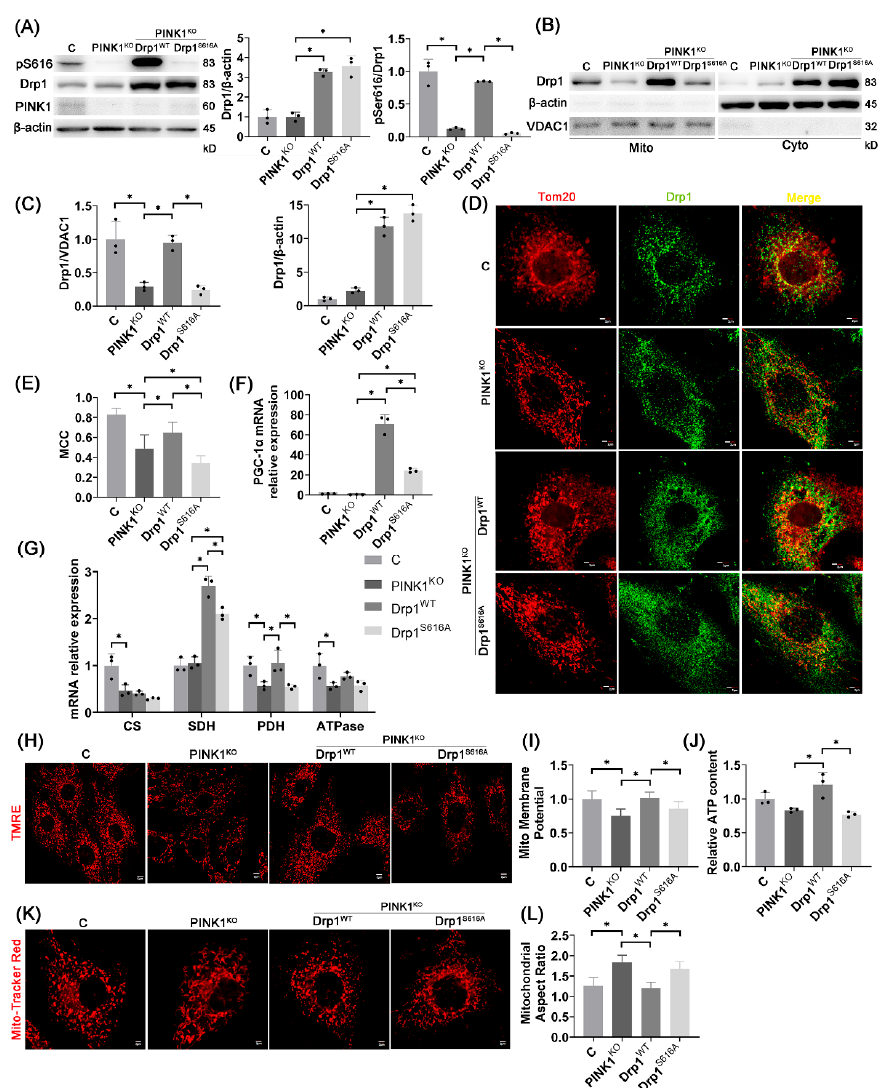
Figure 5. Overexpression of Drp1 WT , rather than Drp1 S616A , improve mitochondrial fission and func- tion. ( A ) PINK1 protein expression, Drp1 total protein level and Drp1 S616 phosphorylation level after PINK1 KO cardiomyocytes overexpressed Drp1 WT or Drp1 S616A ; n = 3 per group. ( B , C ) Drp1 protein levels on mitochondria and in cytoplasm after separation of mitochondrial and cytoplasmic proteins of H9C2 cardiomyocytes; n = 3 per group. ( D , E ) Representative images of immunofluorescence of H9C2 cardiomyocytes (red: mitochondrial outer membrane marker, Tom20, green: Drp1, blue: DAPI, Scale bar: 2 μ m) ( D ) and Manders co-localization coefficient (MCC) quantitative analysis of Tom20 and Drp1 (more than 30 cells analyzed per group) ( E ). ( F , G ) mRNA expression of mitochon- drial function-related gene PGC-1 α ( F ) and CS, SDH, PDH, ATPase ( G ) in H9C2 cardiomyocytes, n = 3 per group. (H, I) Representative images of TMRE mitochondrial membrane potential fluores- cence staining (Scale bar: 5 μ m) ( H ) and quantitative analysis of mitochondrial membrane potential fluorescence intensity (more than 30 cells were analyzed per group) ( I ). ( J ) Relative ATP content of H9C2 cardiomyocytes (normalized using protein concentration, n = 3 per group). ( K , L ) Representa- tive images of MitoTracker Red fluorescent staining of mitochondrial morphology (Scale bar: 2 μ m) ( K ) and quantitative analysis of mitochondrial aspect ratio (more than 30 cells analyzed per group) ( L ). The data are mean ± SD, * p < 0.05 compared to the other group.